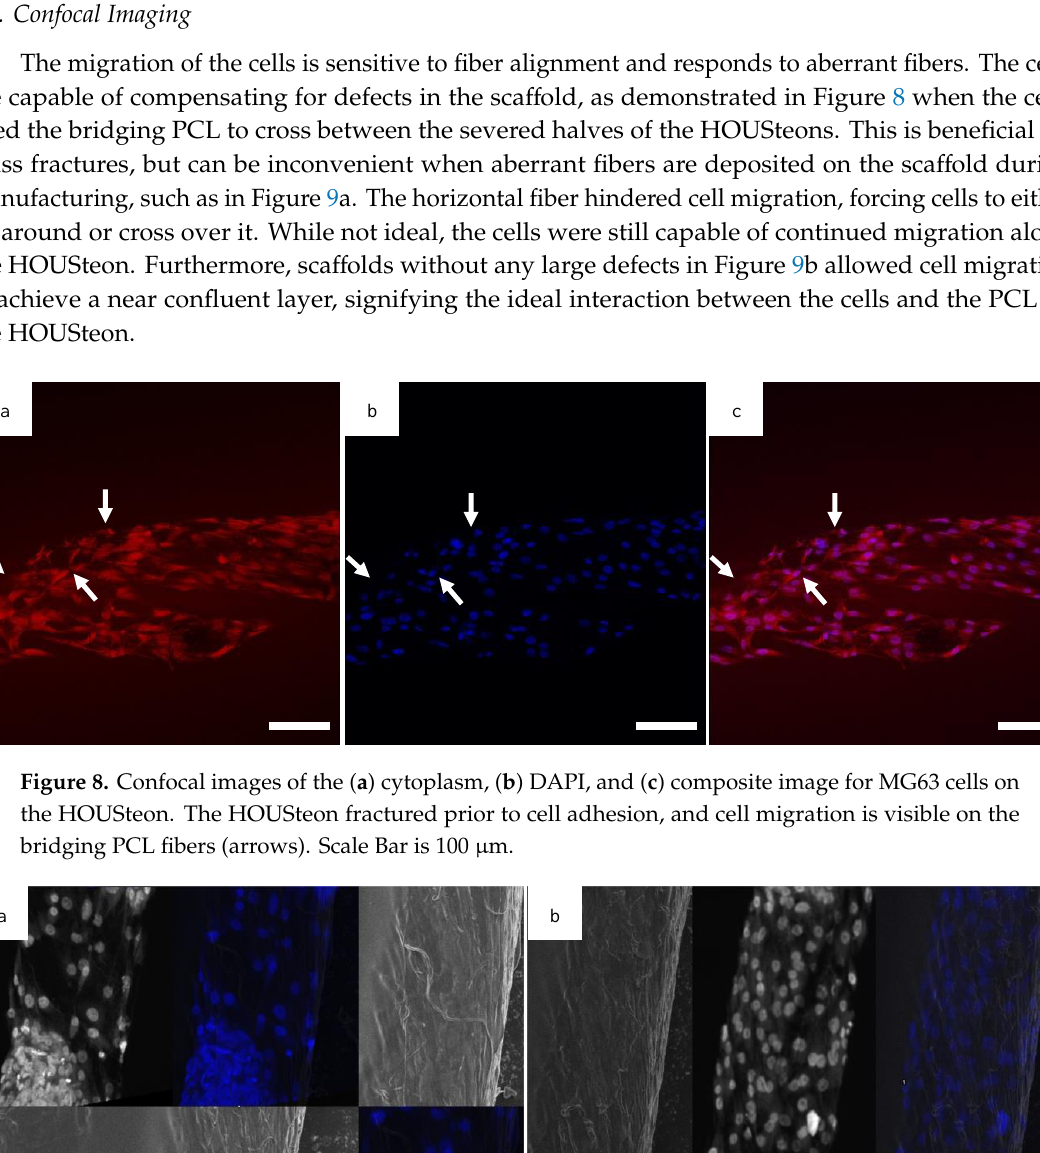
Figure 7. Cell assays of ( a ) in vitro cytotoxicity and ( b,c ) adherence. ( c ) Cells adhered to the scaffolds were normalized to the available surface area on the scaffolds and to the cell control.